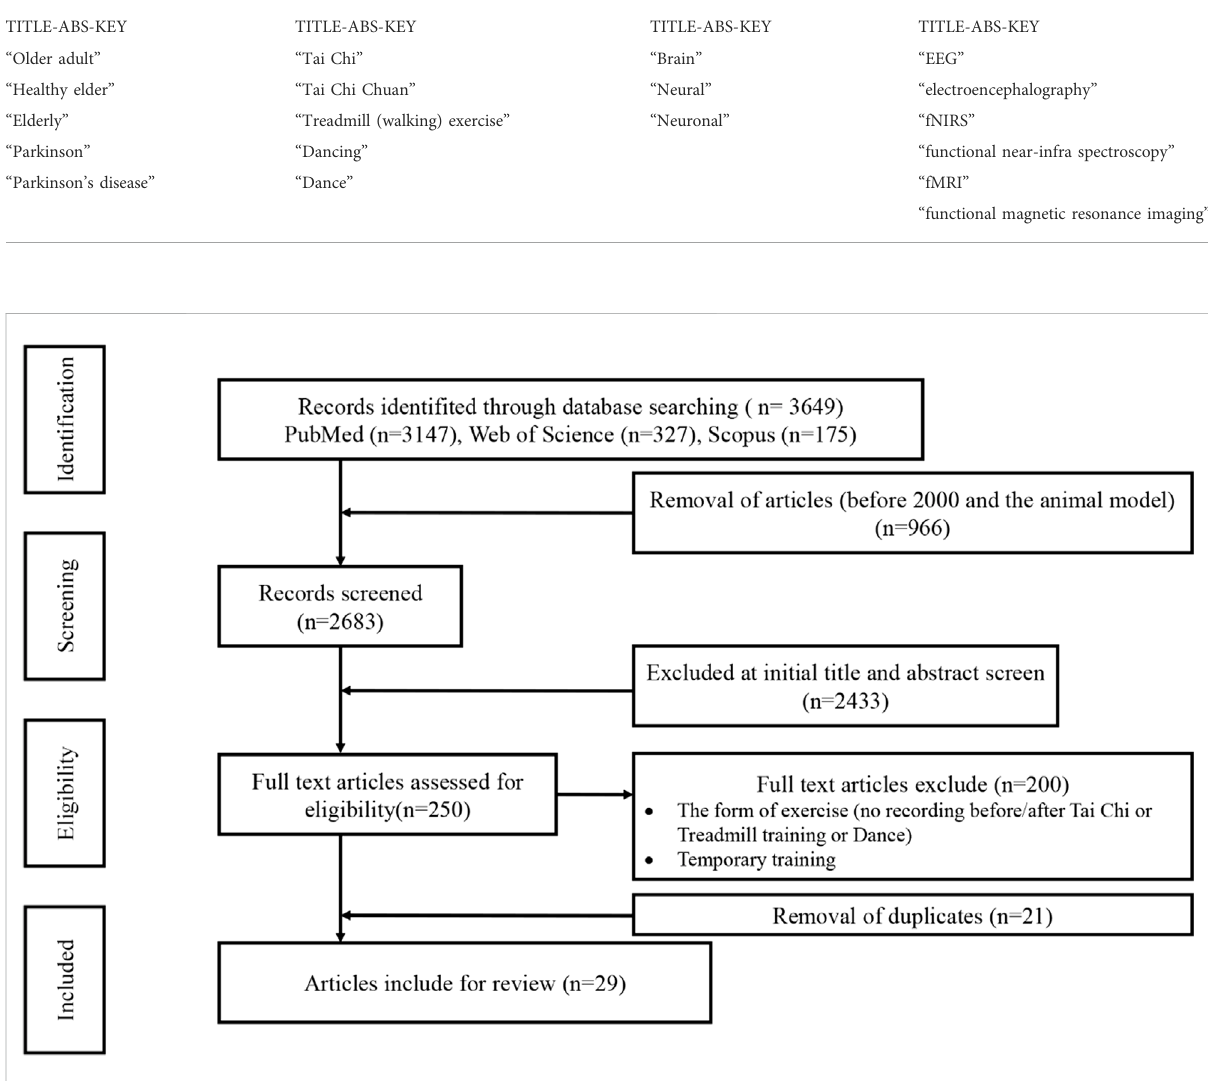
FIGURE 1 PRISMA fl ow chart with information at different stages of the study